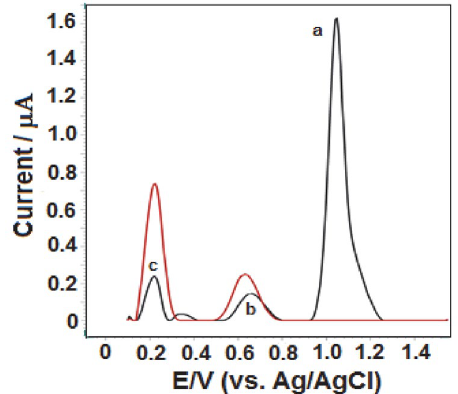
Figure 8. The stripping voltammograms of 1.2 × 10 –7 M pantopra- zole (a) in the presence of 6.0 × 10 –7 M uric acid (b) and 5.3 × 10 –7 M dopamine (c). Red line represents the mixture solutions of uric acid at the same concentrations. Supporting electrolyte, BR buffer, pH 7.0 in the presence of 3 × 10 –4 M CTAB. Other operating condi- tions as indicated in Fig.